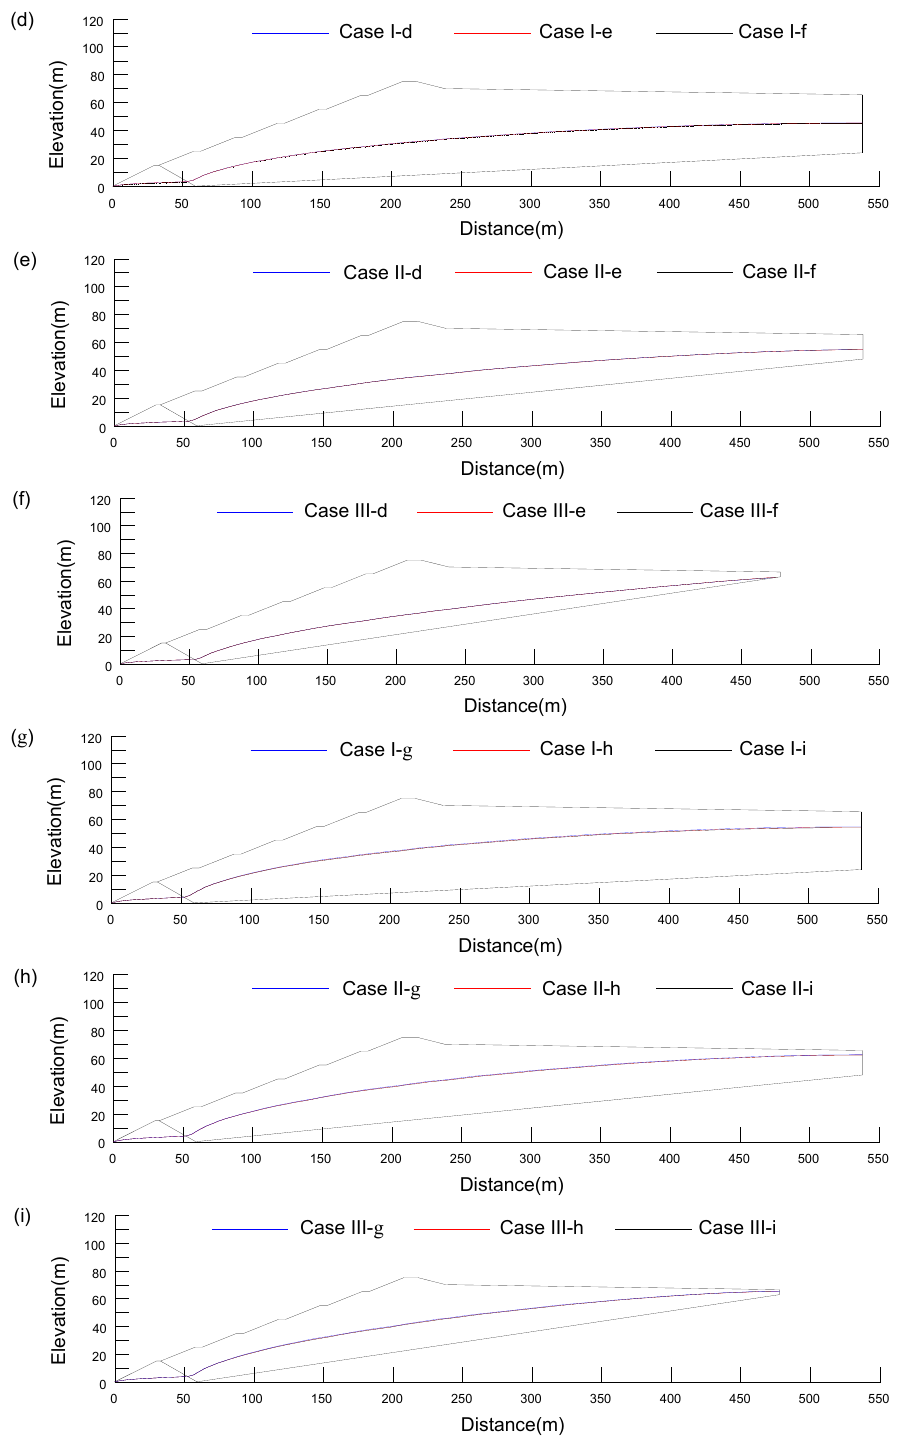
Figure 10. Effects of rainfall patterns: ( a ) Taiyuan 2018, Taiyuan 2019, and Taiyuan 2020 ( i = 0.05); ( b ) Taiyuan 2018, Taiyuan 2019, and Taiyuan 2020 ( i = 0.1); ( c ) Taiyuan 2018, Taiyuan 2019, and Taiyuan 2020 ( i = 0.15); ( d ) Zhengzhou 2018, Zhengzhou 2019, and Zhengzhou 2020 ( i = 0.05); ( e ) Zhengzhou 2018, Zhengzhou 2019, and Zhengzhou 2020 ( i = 0.1); ( f ) Zhengzhou 2018, Zhengzhou 2019, and Zhengzhou 2020 ( i = 0.15); ( g ) Guiyang 2018, Guiyang 2019, and Guiyang 2020 ( i = 0.05); ( h ) Guiyang 2018, Guiyang 2019, and Guiyang 2020 ( i = 0.1); ( i ) Guiyang 2018, Guiyang 2019, and Guiyang 2020 ( i =